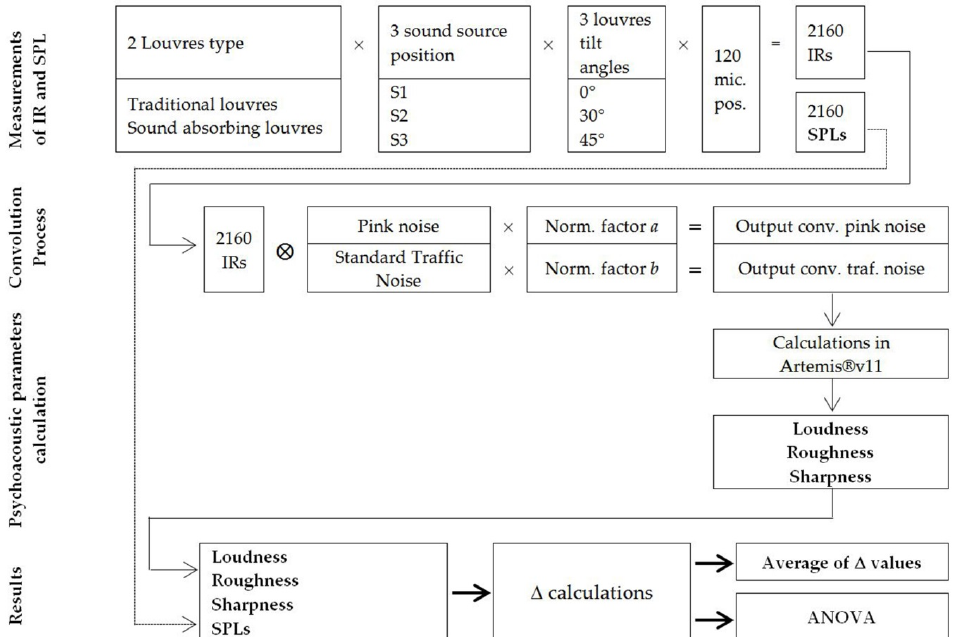
Figure 6. Flow-chart of the entire process to evaluate the acoustic effect of the shading device model: the measurements process with its variables, the convolution process with the two signals, the calculation of the psychoacoustic parameters and the evaluation of the variations over the facade in terms of average values and the statistical analysis of variance (ANOVA).